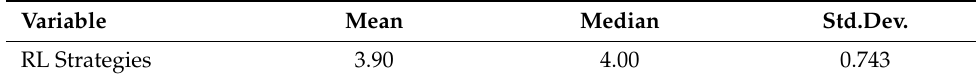
Table 7. RL strategies implemented by FMCG retailers based on